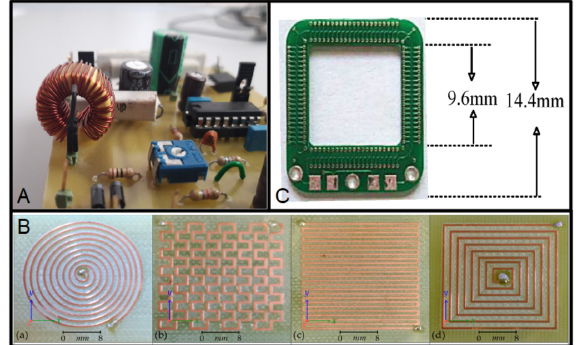
Figure 3. ( A ) Typical inductor assembled to a PCB. ( B ) PCB-based coils with different shapes, (a) Circular planar coil; (b) Mesh planar coil; (c) Meander planar coil and (d) Square planar coil (reprinted from [37], copyright (2018), Creative Commons License). ( C ) Rogowski coil developed on a PCB (reprinted from [38], copyright (2019), Creative Commons